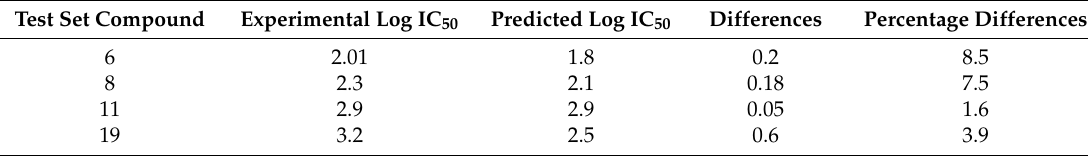
Table 4. Experimental and predicted log IC 50 values of test set